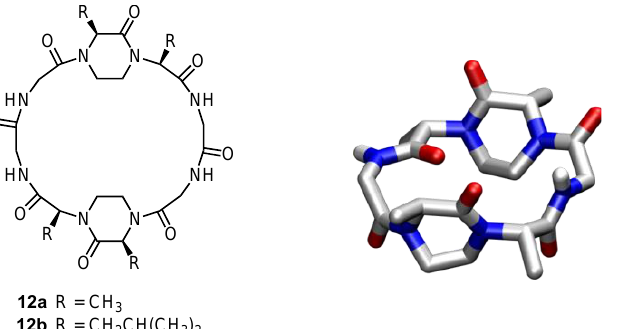
Figure 6. Structures of the cyclic pseudopeptides 12a , b and crystal structure of 12a (CSD Entry: ZARZOH). Solvent molecules and protons, except acidic ones, are omitted for reasons of clarity.